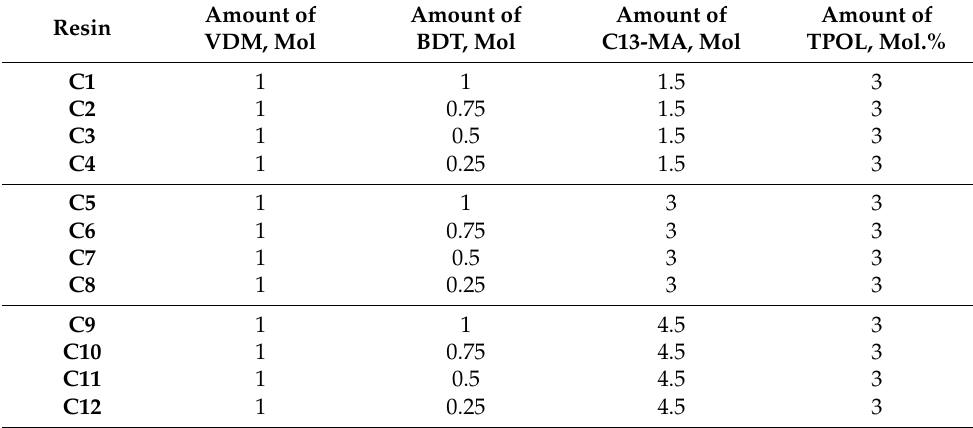
Table 1. Composition of resins C1 - C12.